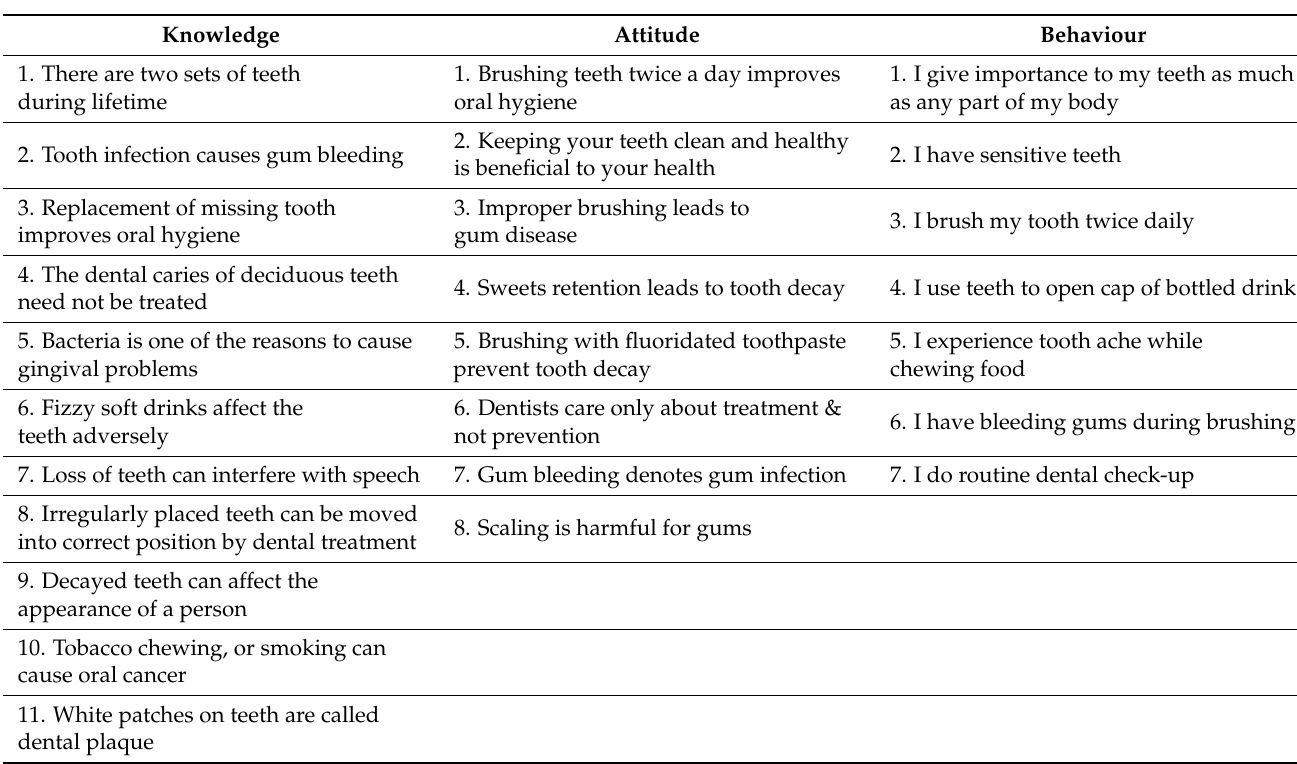
Table 2. KAB questionnaire on oral